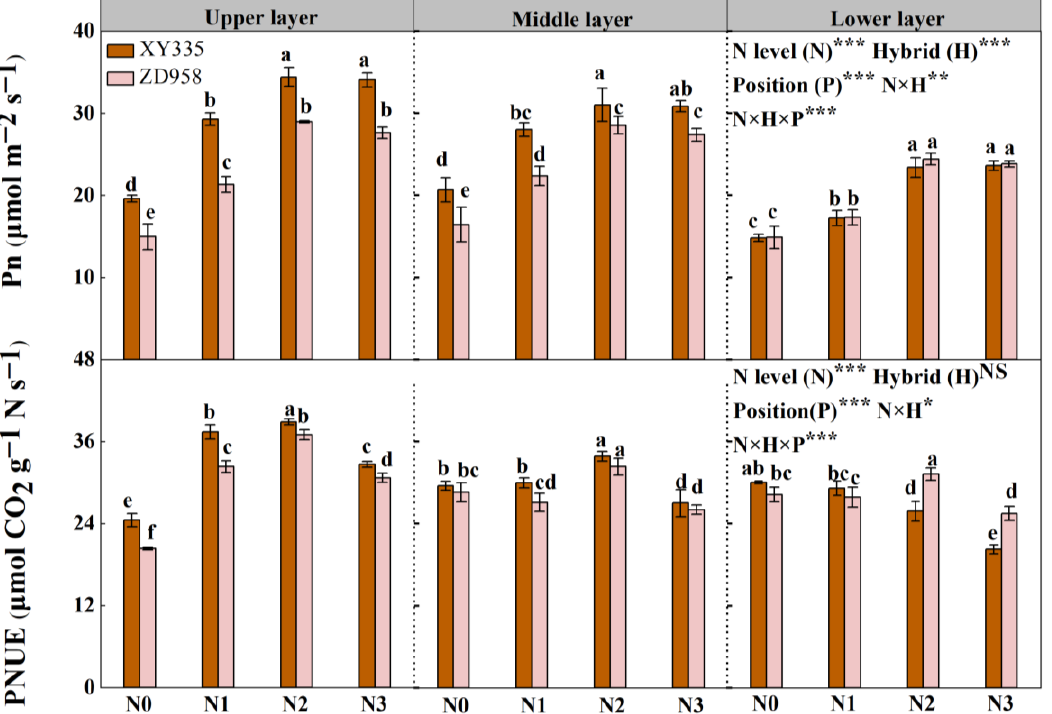
Figure 5. Pn and PNUE of leaves of different maize genotypes at a high plant density in 2015. N0, N1, N2, and N3 indicate applications of 0, 100, 200, and 300 kg N ha −1 , respectively. Different letters indicate a significant difference at the 5% level. Values are shown as the mean ± SE ( n = 3). * p < 0.05, ** p < 0.01, *** p < 0.001. NS, no significance.